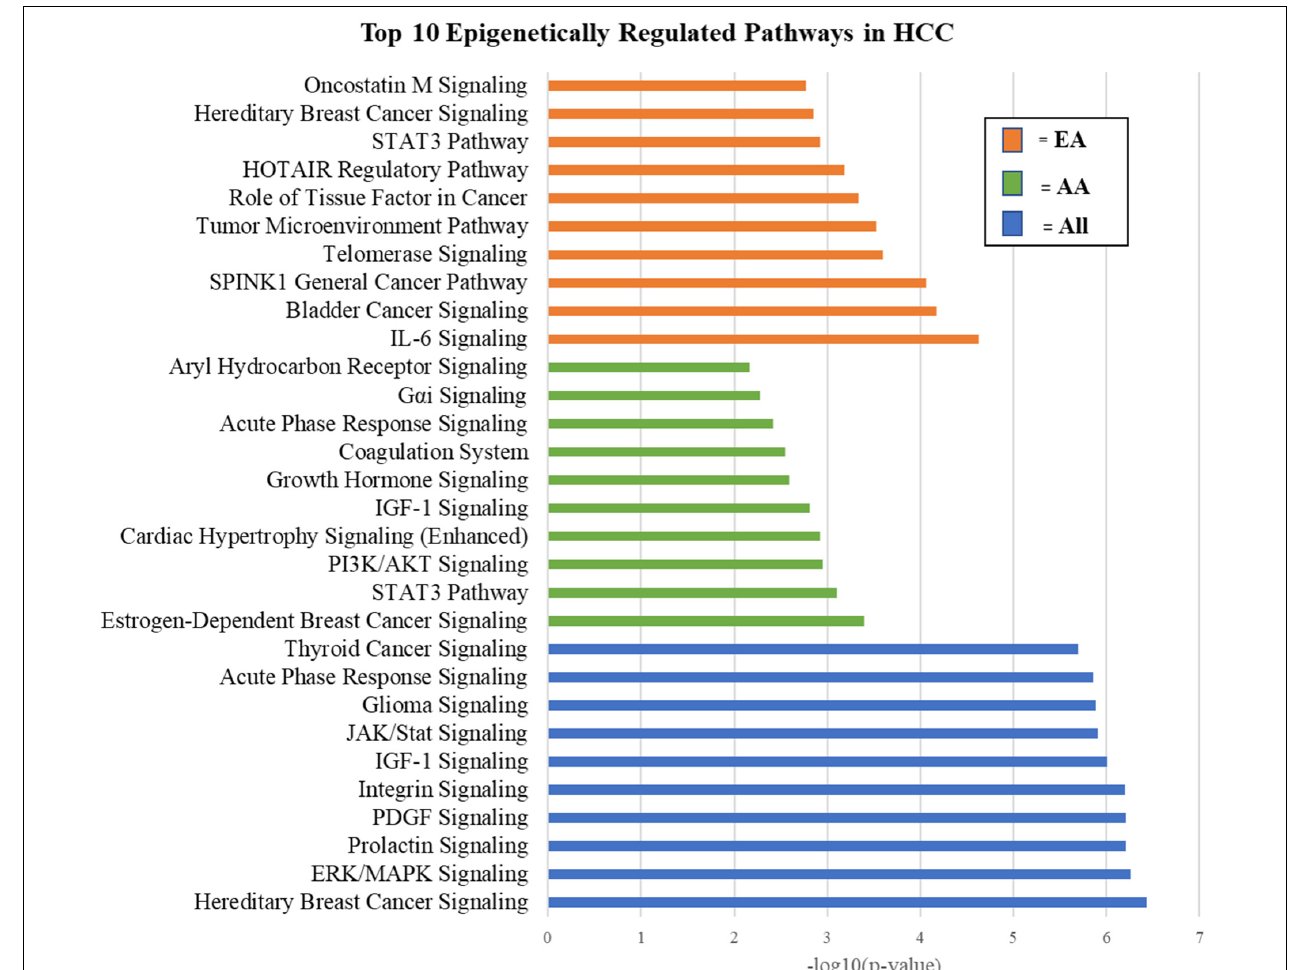
FIGURE 9 | Top 10 epigenetically regulated pathways in